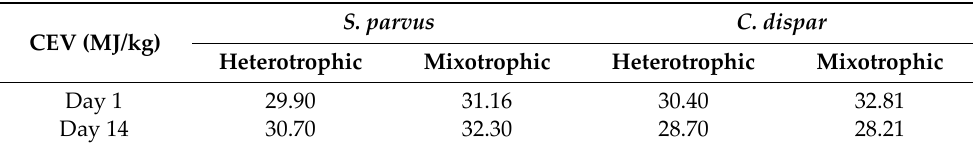
Table 1. CEVs for S. parvus and C. dispar at day 1 and day 14 in the heterotrophic and mixotrophic growth